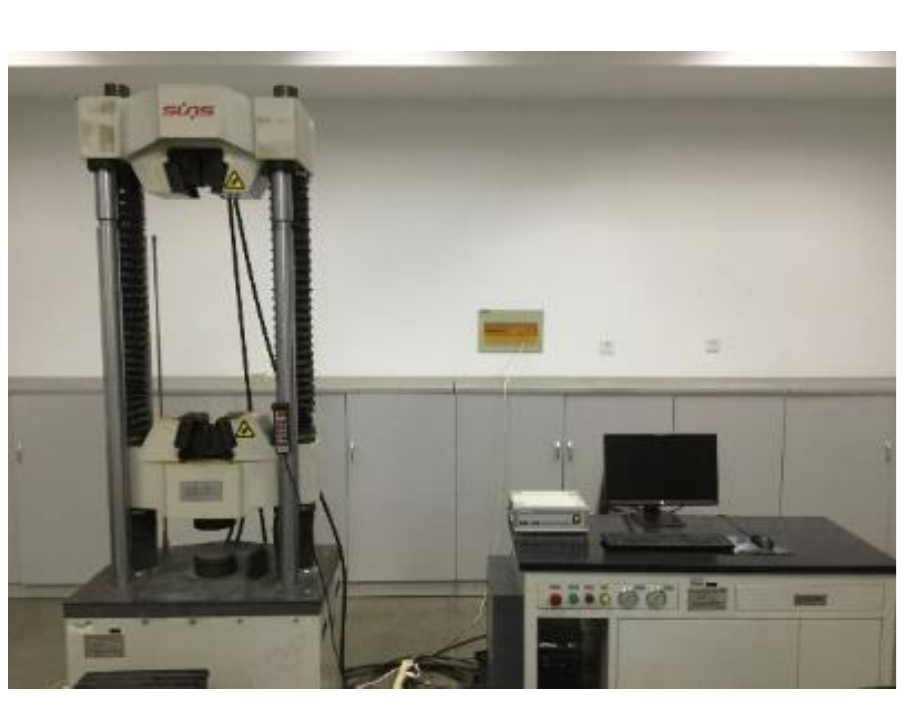
Figure 2. Loading system.